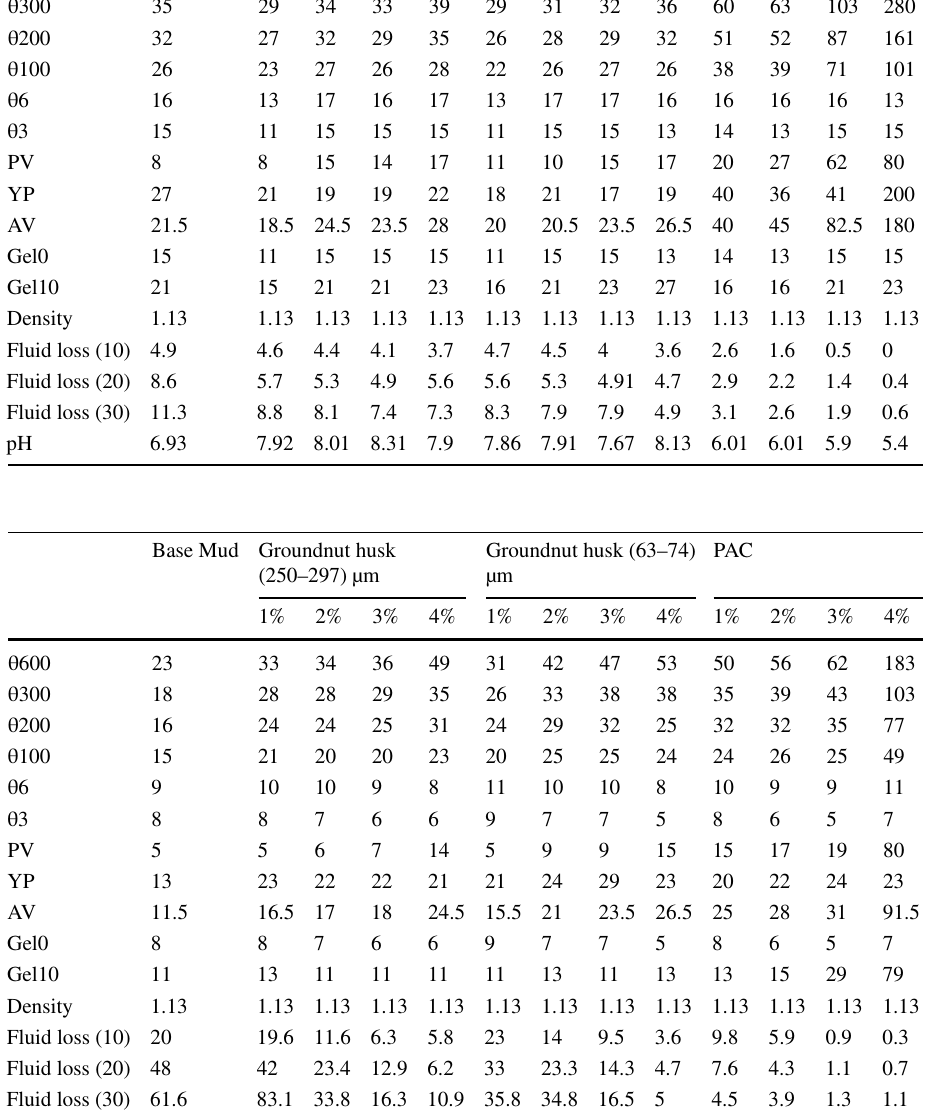
rheological properties of the developed drilling fluid formulations taken before the hot roll